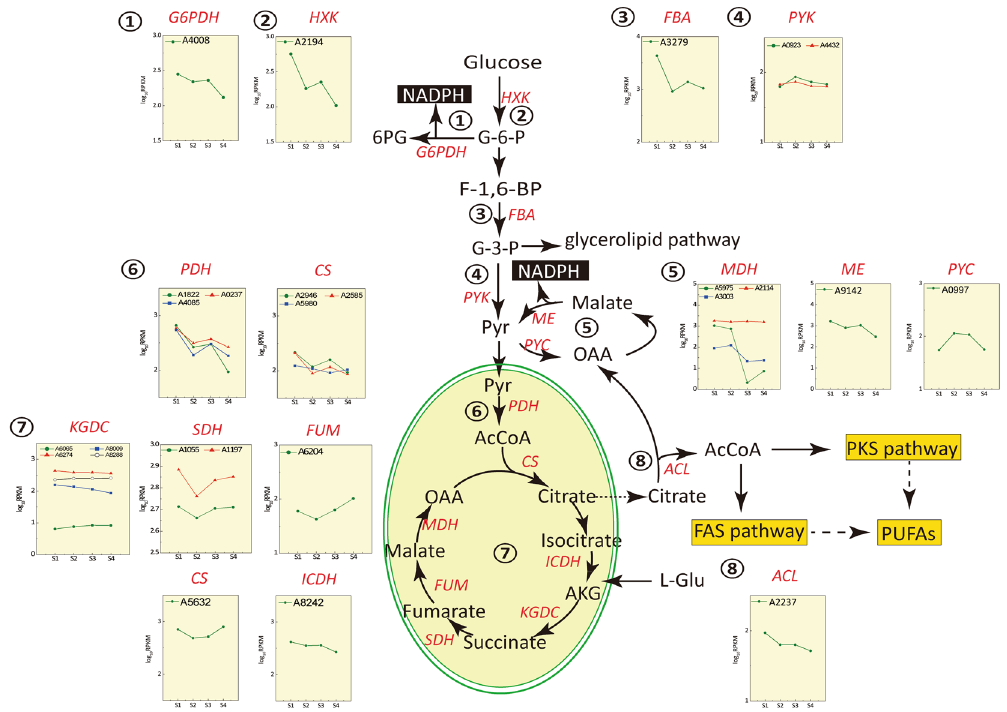
Figure 2. Regulation of NADPH and Acyl-CoA synthesis in Schizochytrium sp. HX-308. G6PDH: Glucose-6- phosphate dehydrogenase; HXK: Hexokinase; FBA: Fructose 1,6 bisphosphate aldolase; PYK: Pyruvate kinase; MDH: Malate dehydrogenase; ME: malic enzyme; PYC: Pyruvate carboxylase; PDH: Pyruvate dehydrogenase; KGDC: Ketoglutaricdehydrogenase; SDH: Succinate dehydrogenase; FUM: Fumarate hydratase; CS: Citrate synthase; ICDH: Isocitrate dehydrogenase; ACL: ATP citrate